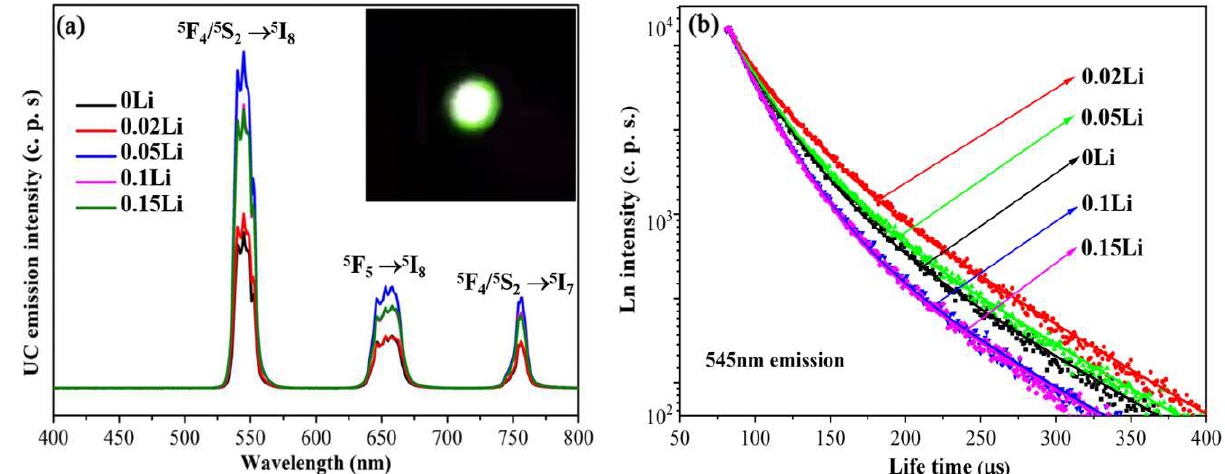
Figure 5. ( a ) UC PLS pumped by a 980 nm laser and the pumping power and its density were set to be 245 mW and 613 mW/cm 2 , respectively ( b ) decay time of carriers on 5 F 4 / 5 S 2 level of Ho 3+ for BHYTO: x Li ( x = 0, 0.02, 0.05, 0.10, 0.15) phosphors monitored at 545 nm emission.